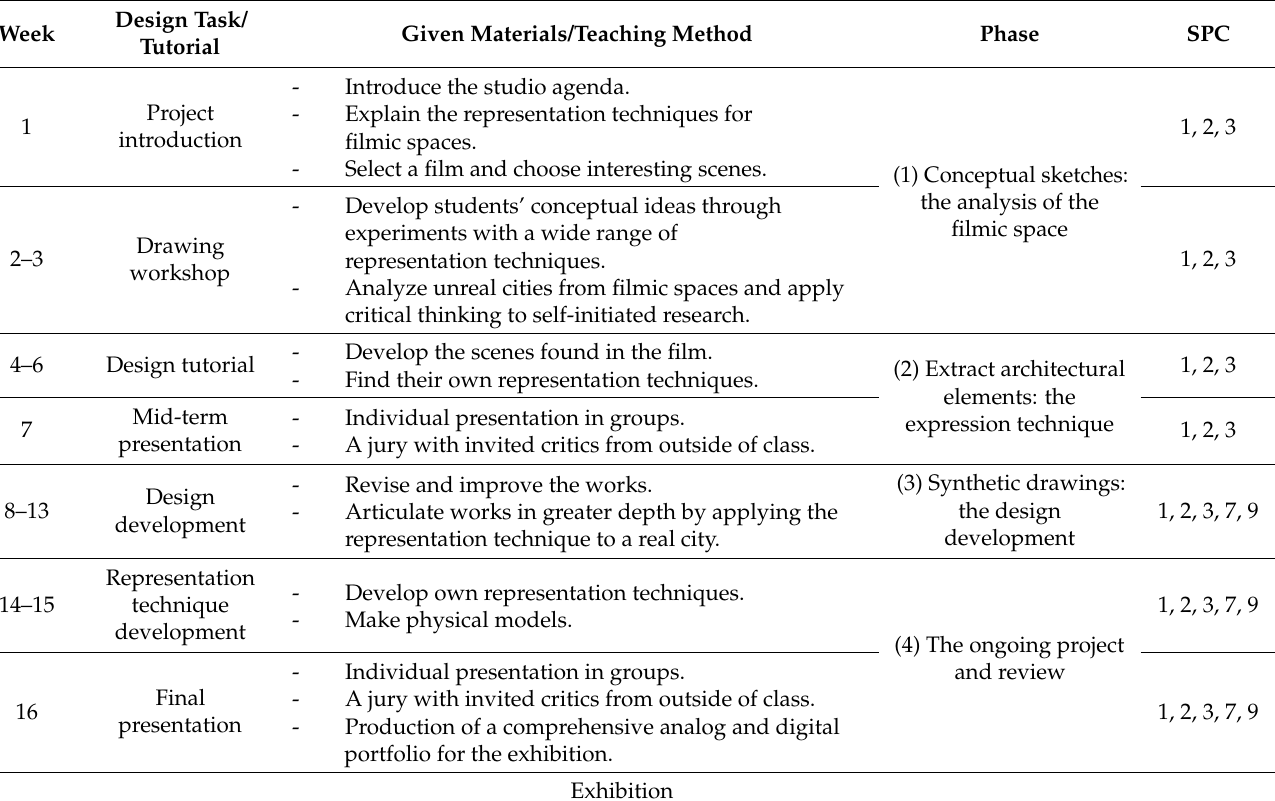
Table 2. Studio course schedule and teaching methods .